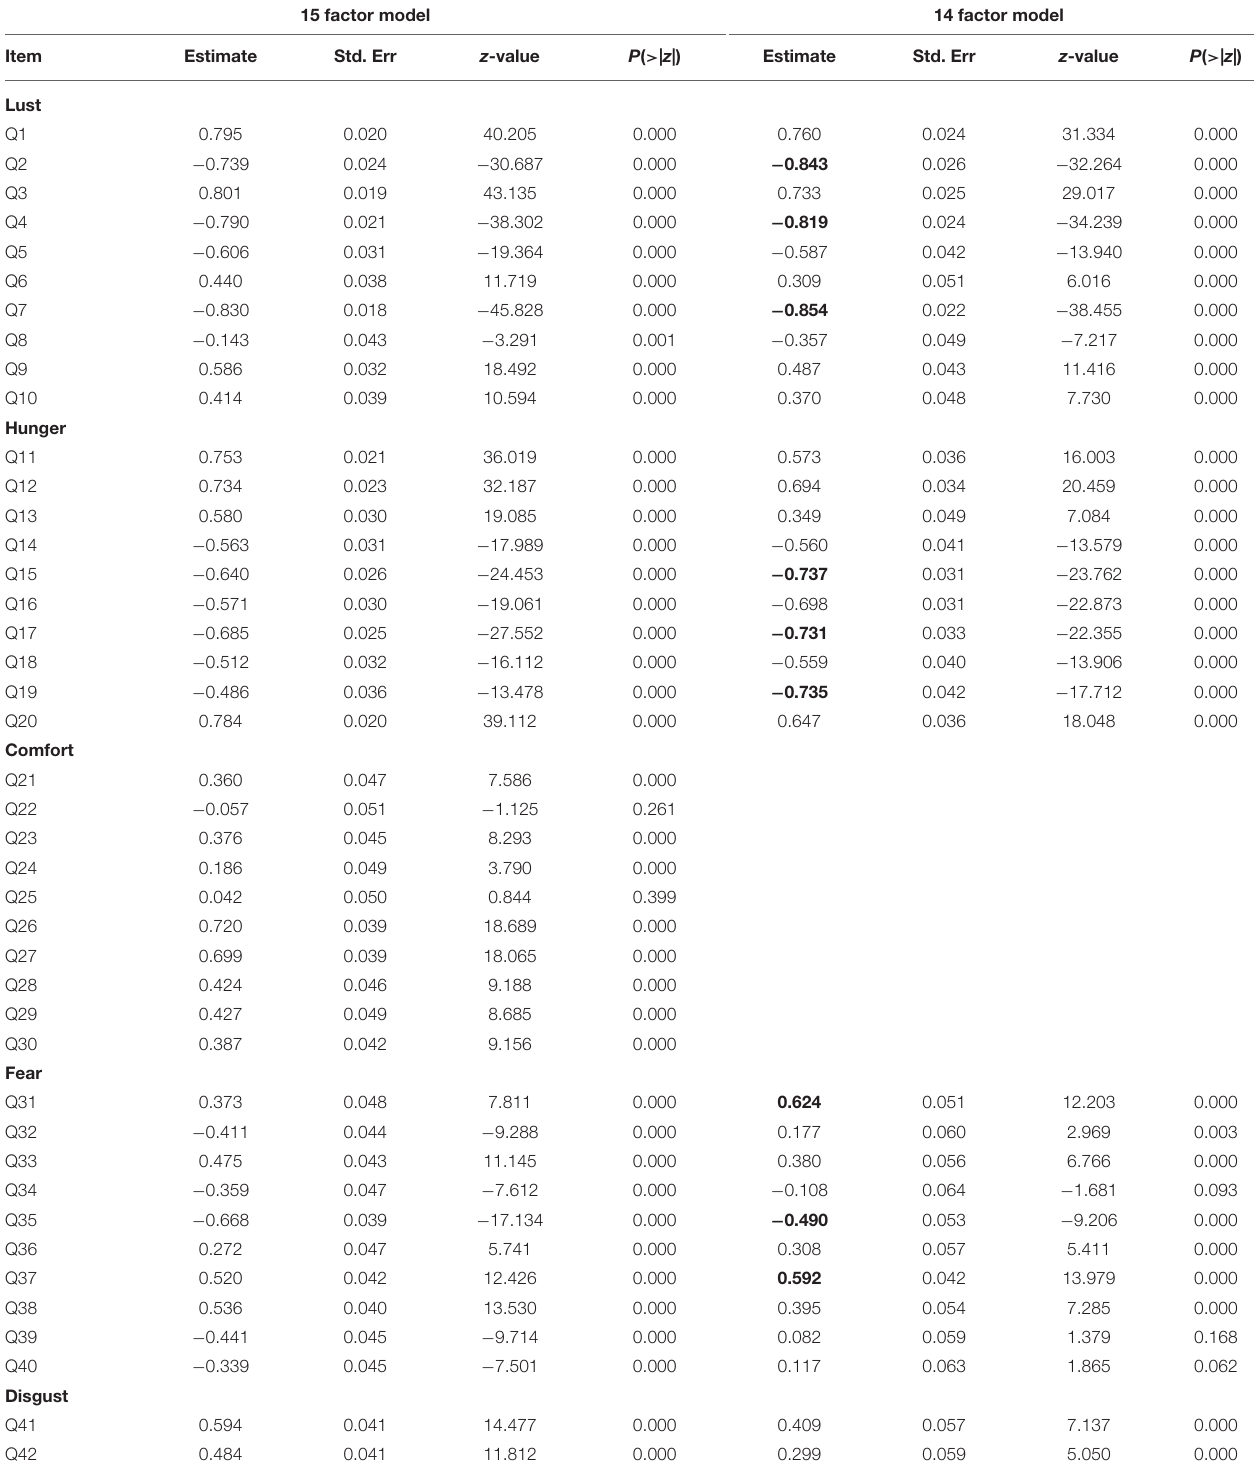
TABLE 3 | CFA model